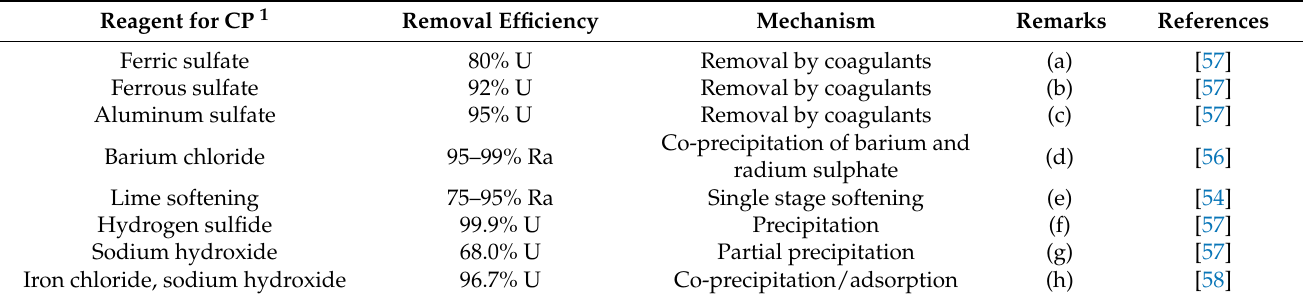
Table 2. Summary of the chemical precipitation (CP) performance for uranium